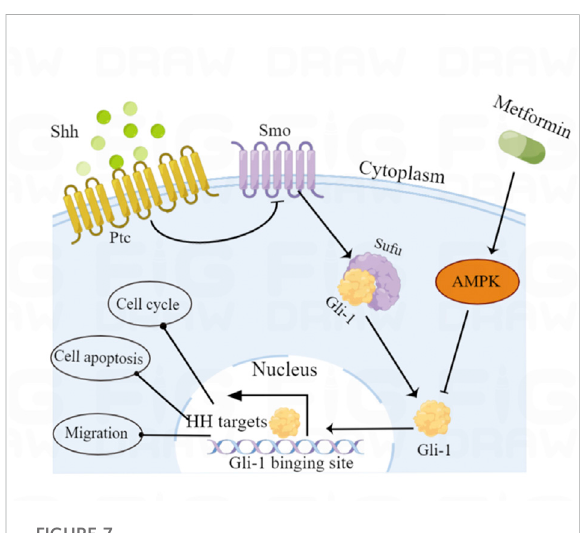
FIGURE 7 Schematic diagram of the proposed molecular mechanism by which metformin exerts anticancer effects via AMPK-mediated inhibition of the Shh signaling pathway in